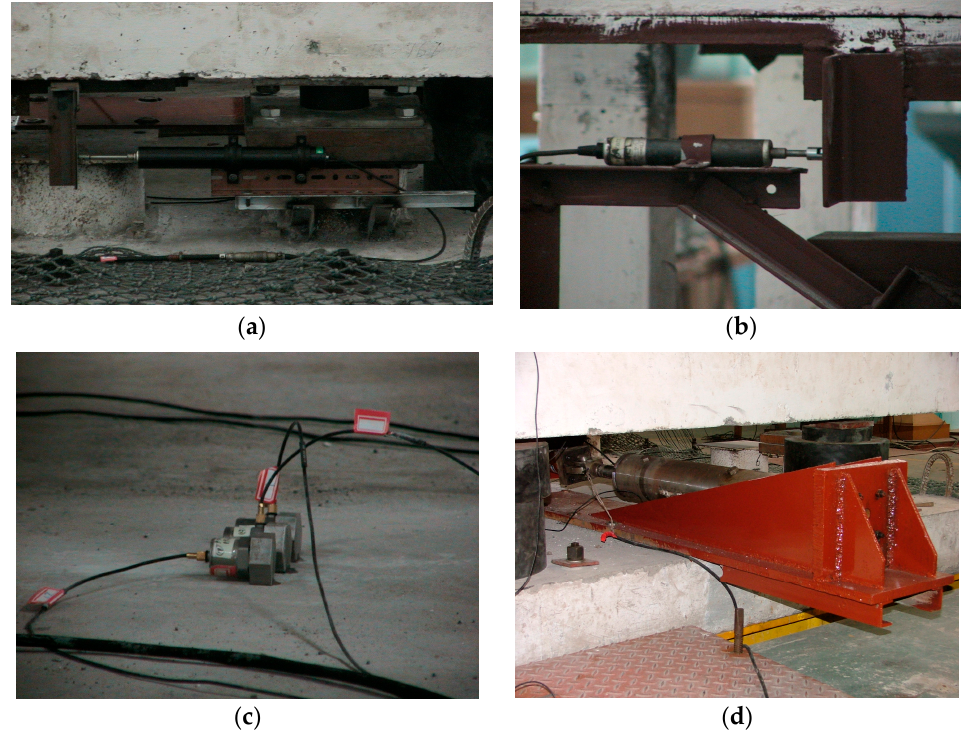
Figure 8. Sensors arrangement. ( a ) linear variable differential transformer (LVDT) displacement sensor in isolation layer; ( b ) LVDT displacement sensor in the bottom layer; ( c ) three acceleration sensors; ( d ) magnetorheological (MR) damper in isolation layer.